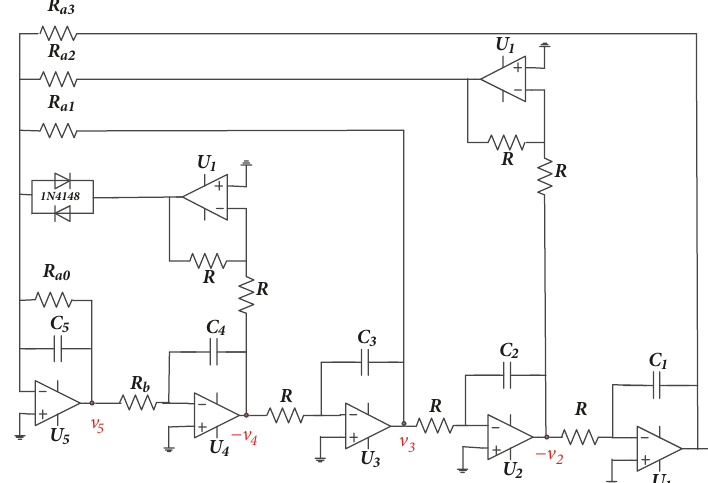
Figure 1: Electronic circuit of the proposed 5-D hyperjerk